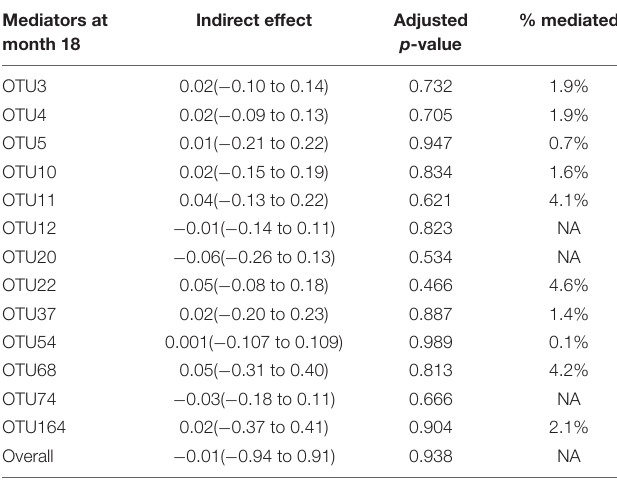
TABLE 5 | Mediation effect of gut microbiome on ADHD at 54 months ( n =